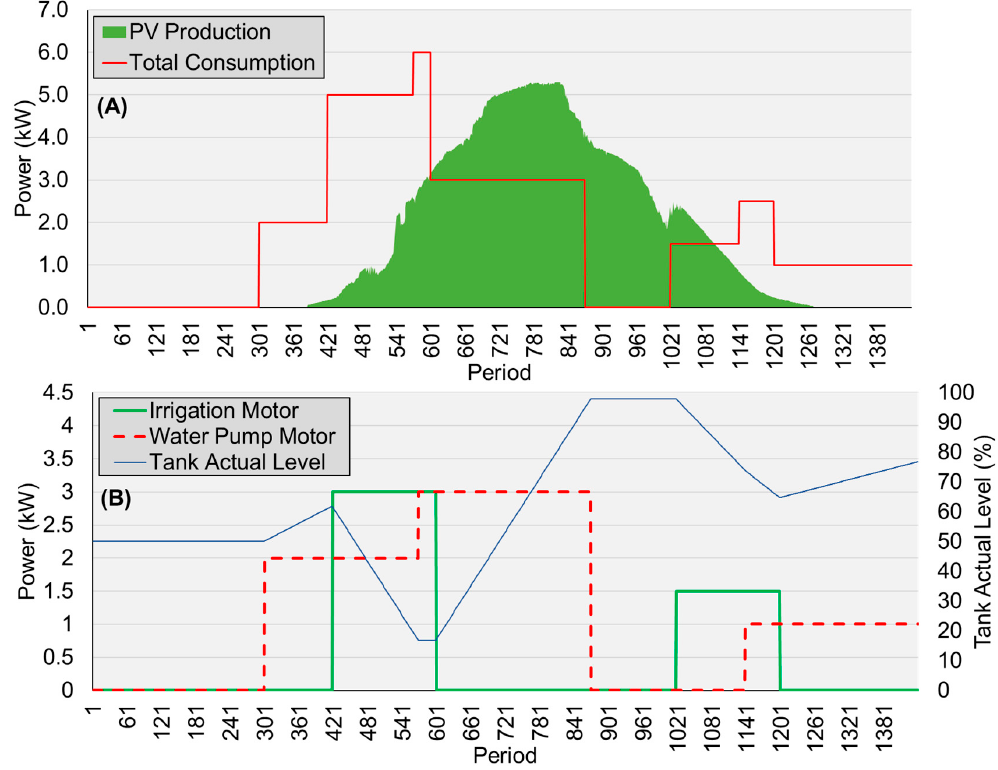
Figure 6. Consumption and generation profiles of the system for 24 hours: ( A ) total consumption and generation of the system; ( B ) energy consumed by the employed equipment.